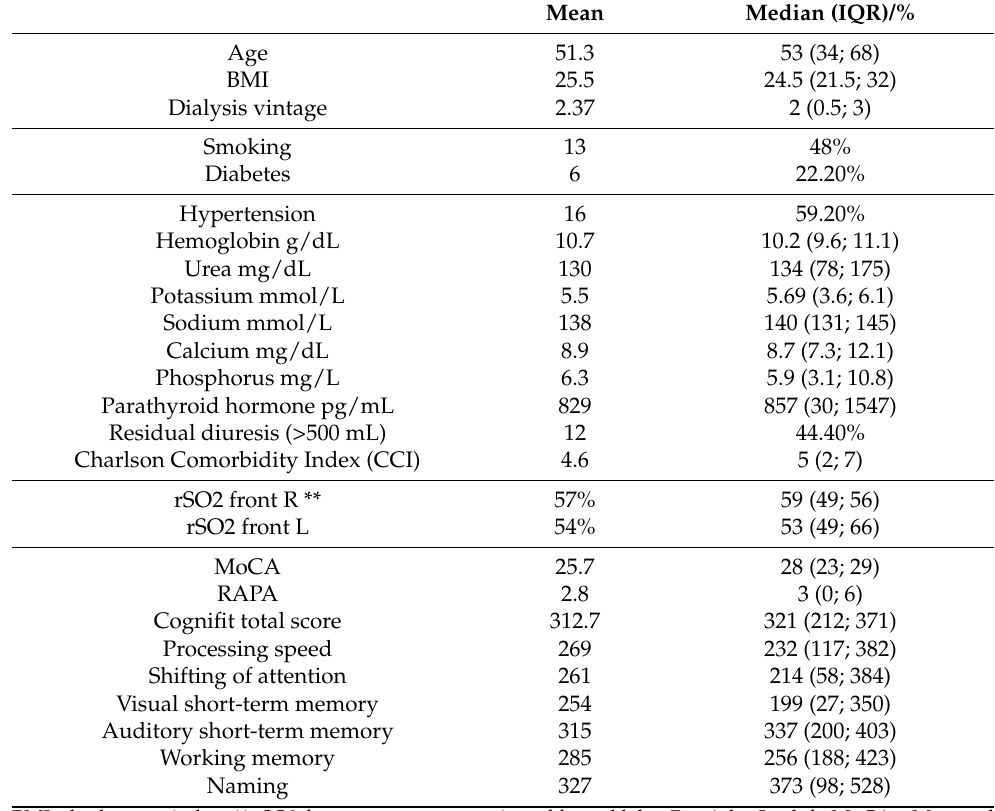
Table 1. Patients’ characteristics and results.